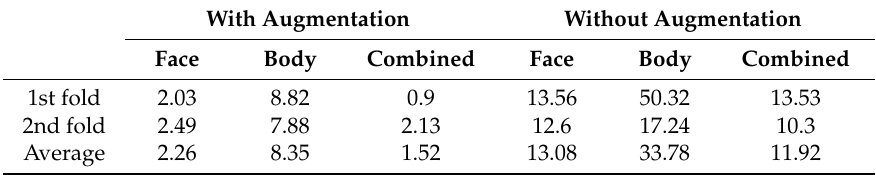
Table 10. Comparisons of EERs with and without data augmentation (unit: